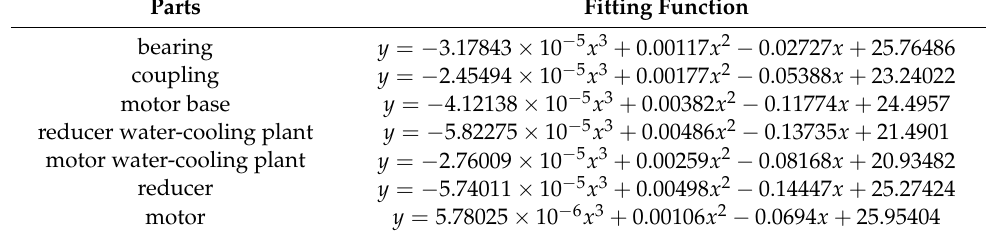
Table 7. Fitting function of temperature measurement points of each component under different flows. Parts Fitting Function